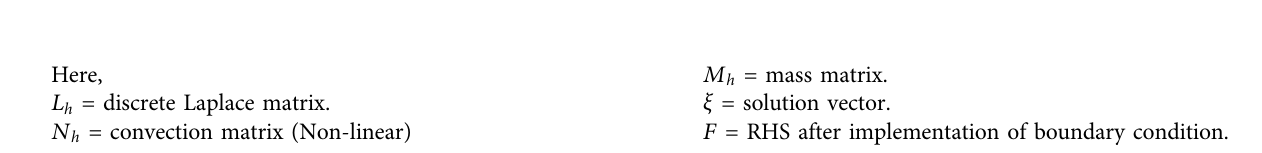
Frontiers in Physics |